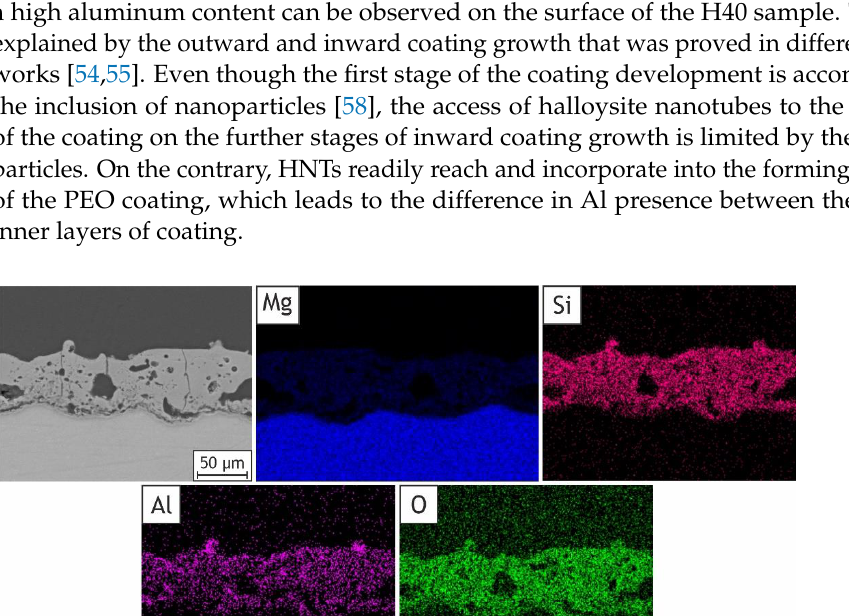
Figure 7. SEM image and EDS maps of elements distribution for the H40 sample: Mg, Si, Al, O, Na.